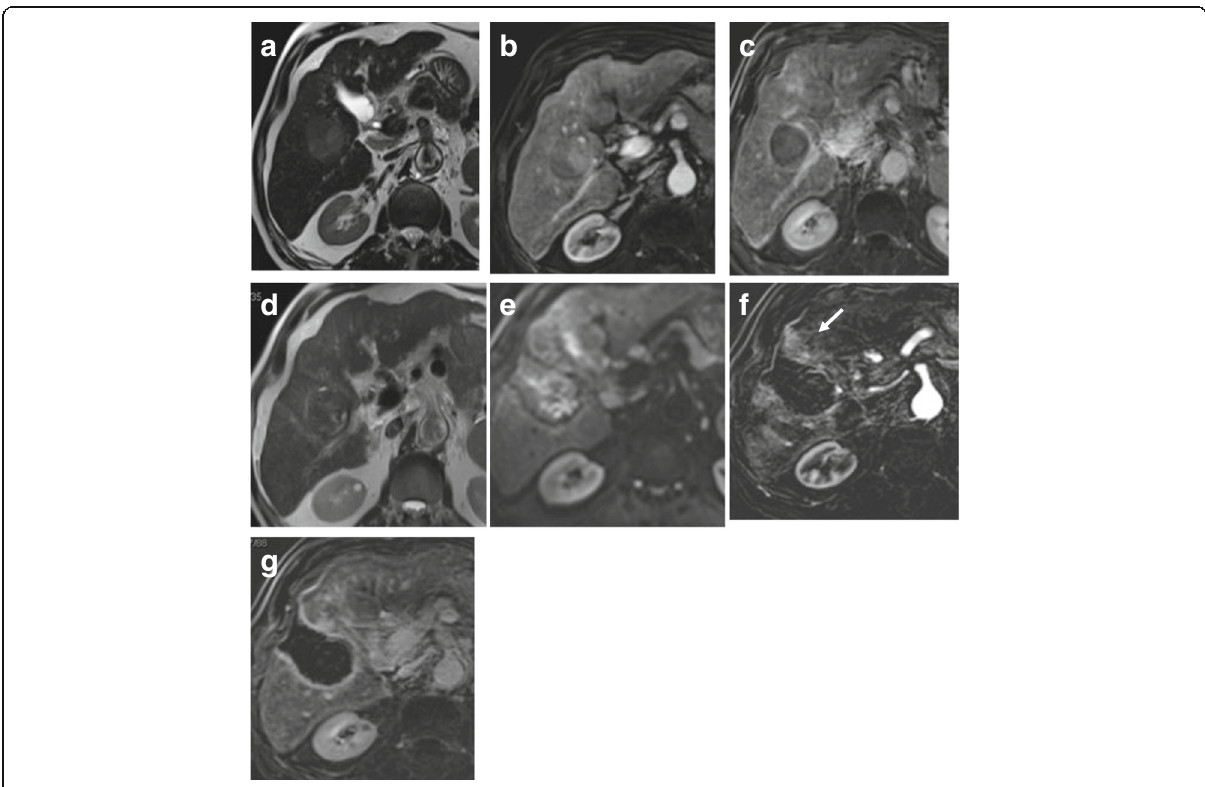
Fig. 4 Hepatic focal lesion before ( a – c ) and after RFA ( d – g ). a T2-WI shows a well-defined HFL of an intermediate signal. b Enhanced T1-WI in the arterial phase shows early arterial heterogeneous enhancement. c Enhanced T1-WI in the delayed phase shows washout with delayed capsule enhancement. d After treatment, T2-WI shows a low signal with peripheral hyperintensity. e DWI shows central areas of restriction. f Subtracted T1-WI arterial phase shows non-enhancement of the lesions with faint peripheral enhancement (arrow). g Delayed T1-WI shows persistent peripheral enhancement. Final diagnosis is LR-TR nonviable with post-therapy